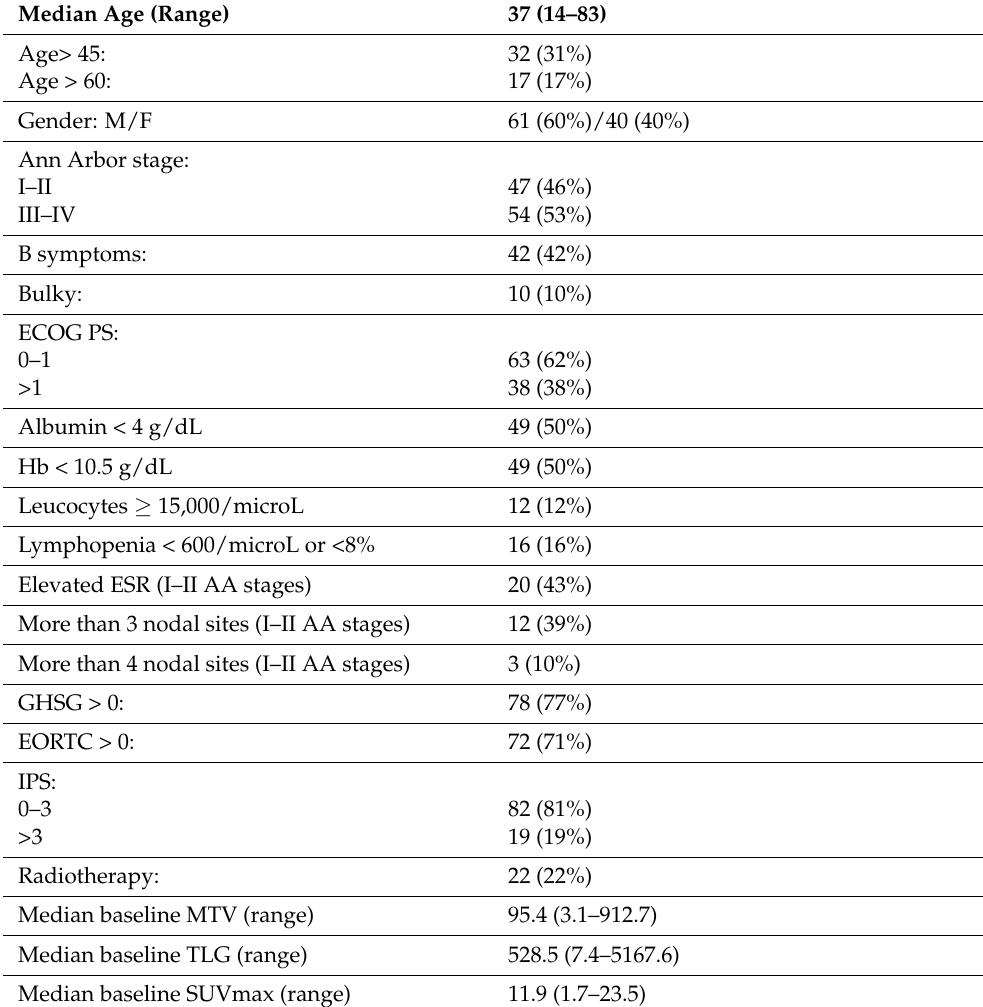
Table 1. Characteristics of